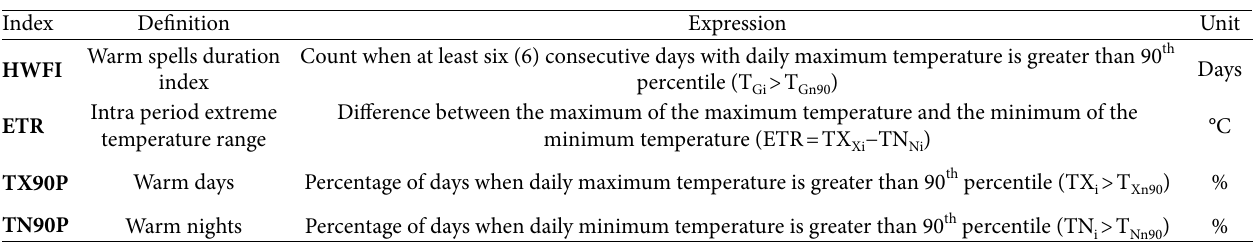
Table 2: The ETR and ETCCDI (HWFI, TX90P and TN90P) temperature indices. The terms T Xn90 , T Nn90 , T Gn90 are the 90 th percentile of the maximum, minimum and mean temperature, and the terms T Gi , T Ni , T Xi , indicate the mean, minimum and maximum temperature, is the minimum of the minimum temperature and TX is the maximum of the maximum temperature. All these terms are respectively. TN Ni Xi used to calculate the ETR and ETCCDI (HWFI, TX90P and TN90P) indices that are given in